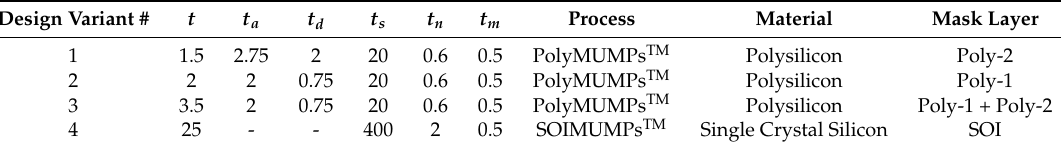
Table 2. Design variants of the studied microgripper structure. The given nominal thicknesses are in µ m and are annotated in Figure 2. The thickness parameters are defined by the respective fabrication process and the mask layers